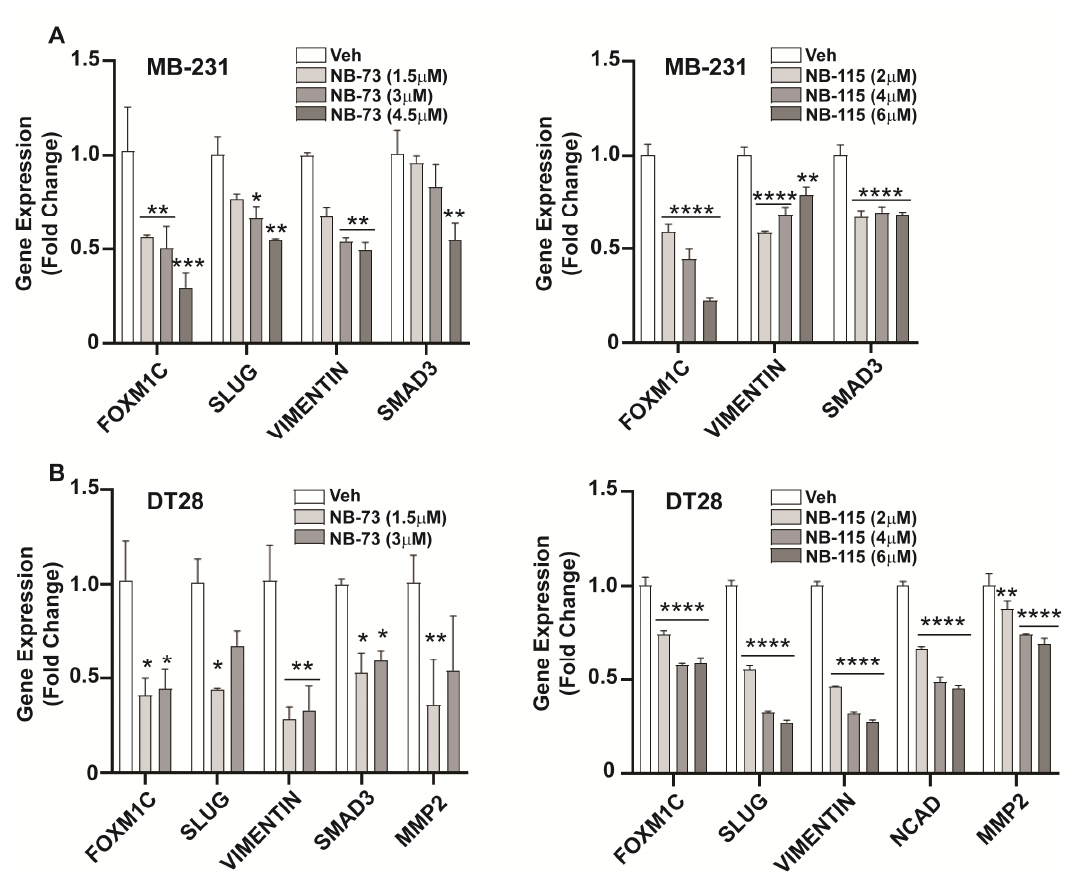
Figure 3. Downregulation of EMT-associated gene expression in inhibitor-treated TNBC cells, ( A ) MDA-MB 231 and ( B ) DT28 cells were treated for 24h with various concentrations of NB-73 and NB-115 followed by RNA extraction and qPCR analysis of EMT related gene expressions. Statistical analysis used 2-way ANOVA and * p < 0.05, ** p < 0.01 and *** p < 0.001 are indicated; mean ± SEM.